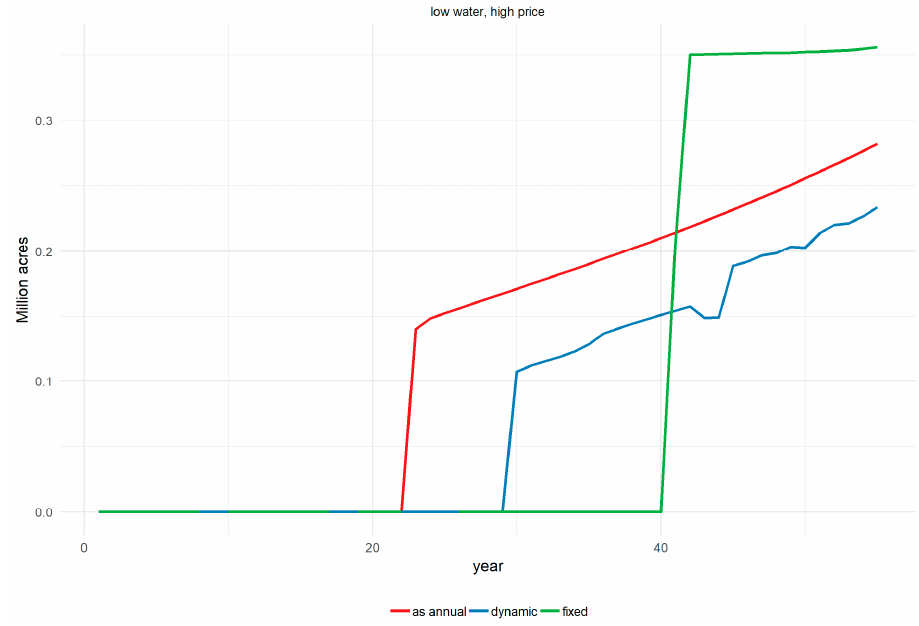
Figure 8. Fallowing in the “low water, high price” scenario.